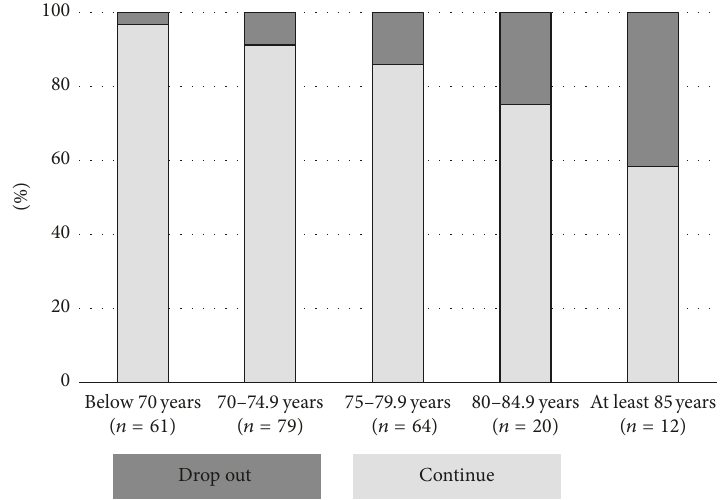
Figure 1: Associations between age categories and risk of drop-out (chi-square statistics, 𝑃 < 0.001 ).